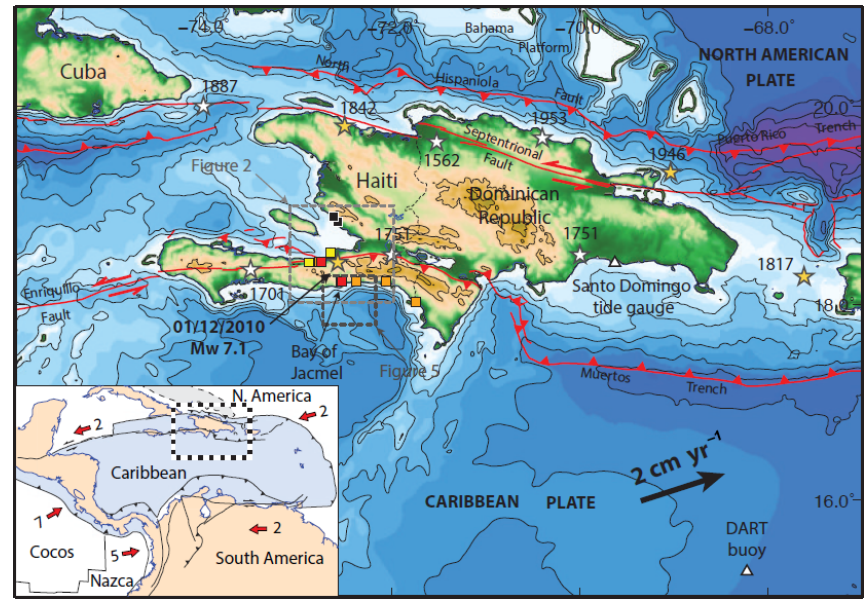
Figure 1. Regional tectonic context. The yellow star indicates the epicenter of the 2010, M w 7.1 Haiti earthquake. Other yellow stars indicate the approximate epicenter of large historical tsunamigenic earthquakes, in particular the 1842 event of northern Haiti, which is discussed in the text. White stars show the approximate location of other large historical earthquakes. Tsunami run-up heights observed after the 2010 event are indicated by squares: < 1m (yellow), 1 to 2m (orange), > 2m (red), draw down (black). The locations of DART buoy 42407 and the Santo Domingo tide gauge are indicated by white triangles. The inset shows the large-scale tectonic framework with current plate velocities relative to the Caribbean shown in centimeters per